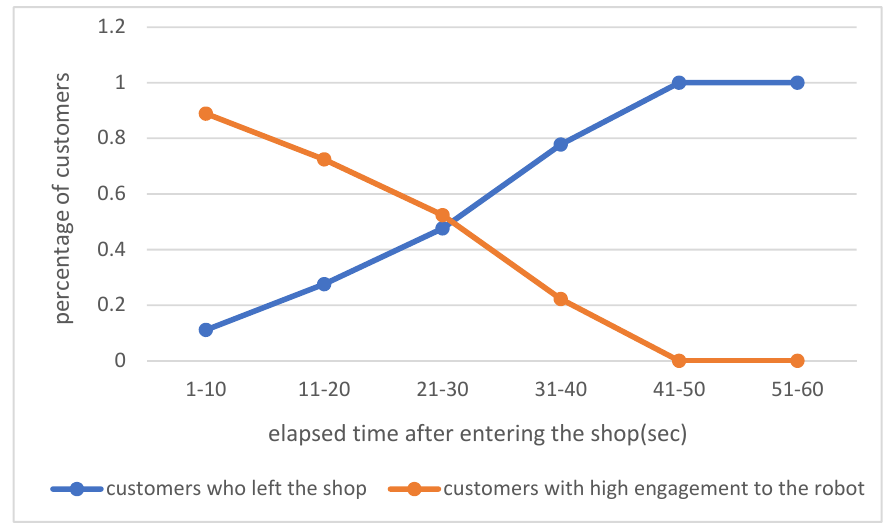
Figure 6. Changes over time in the percentage of customers greeted by robots and departing customers when using the automatic greeting mode (high engagement: value more than 0.6).